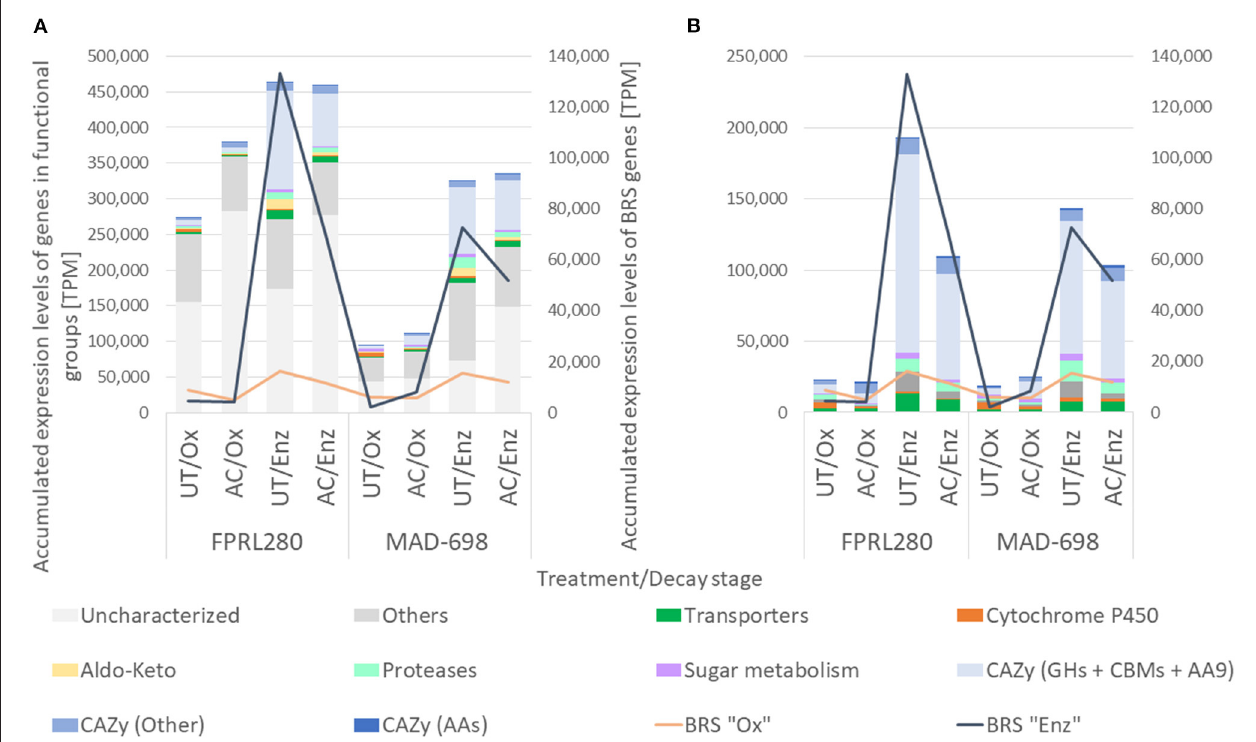
FIGURE 5 | TPMs of the different groups are shown with bars in different colors. (A) The graphic shows the results for the differences between untreated and acetylated samples during the oxidative and the enzymatic phase for the two strains of R. placenta . G. trabeum was excluded due to a better readability of the graphic and can be found in Supplementary Figure 4A . (B ) To enhance the readability, the groups of “Uncharacterized” and “Others” were excluded. A more detailed view on the single gene groups can be found in Supplementary Figures 4B–M .